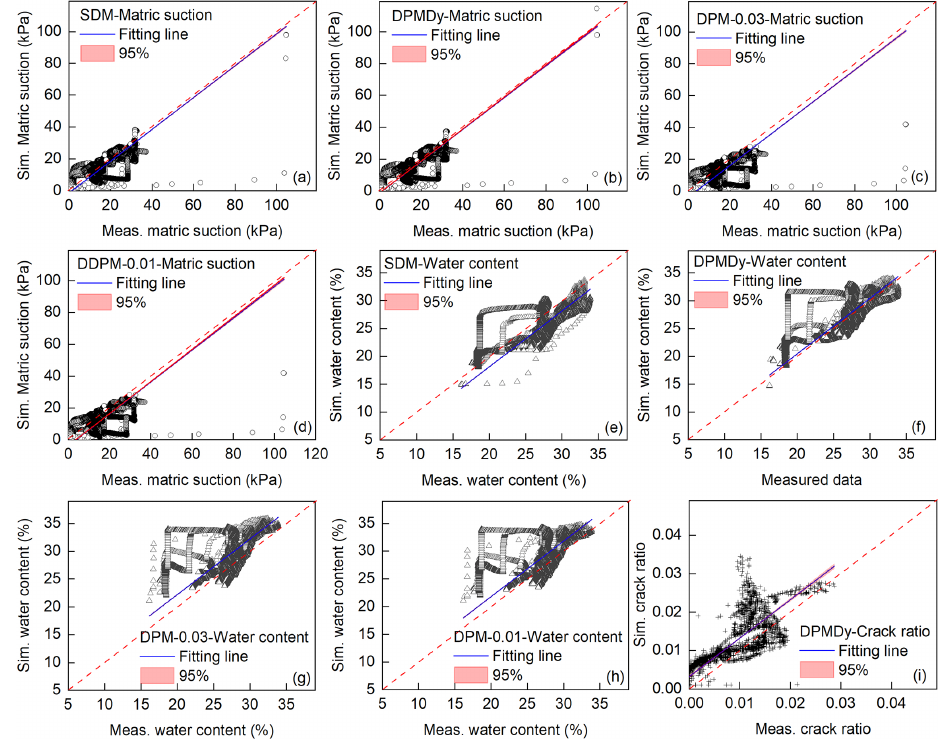
Figure A3. Scatter plots of modeled vs. measured data. Panels (a) , (b) , (c) and (d) refer to the matric suction simulated by SDM, DPMDy, DPM-0.03 and DPM-0.01, respectively; panels (e) , (f) , (g) and (h) refer to the volumetric water content simulated by SDM, DPMDy, DPM- 0.03 and DPM-0.01, respectively; and panel (i) refers to the crack ratio simulated by DPMDy. “Sim.” means “simulated”, and “Meas.” means